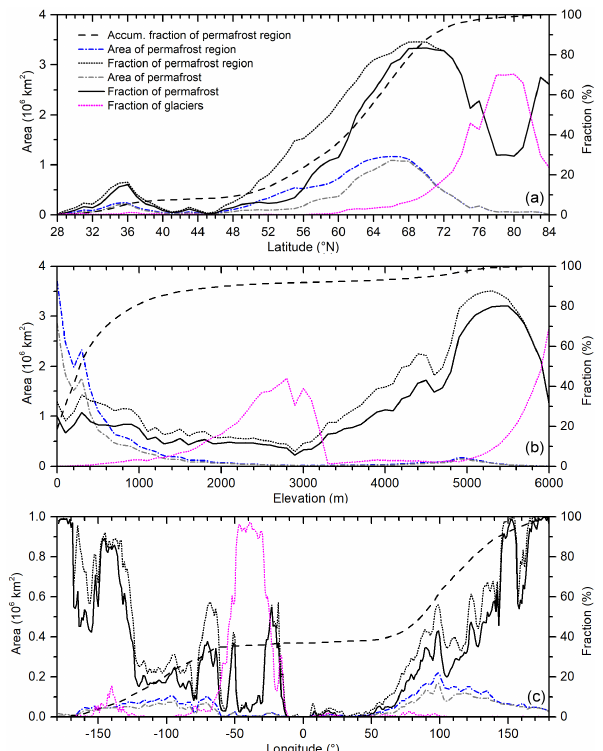
Figure 8. Distributions of the permafrost region (permafrost proba- bility > 0) and permafrost area (MAGT ≤ 0 ◦ C) along northern lat- itude (a) , elevation (b) , and longitude (c) transects in the Northern Hemisphere (blue short dash–dot line: area of permafrost region; grey short dash–dot line: area of permafrost region; black dotted line: fraction of permafrost region; black dashed line: accumula- tion fraction of permafrost region; black solid line: fraction of per- mafrost area; magenta dotted line: fraction of glacier